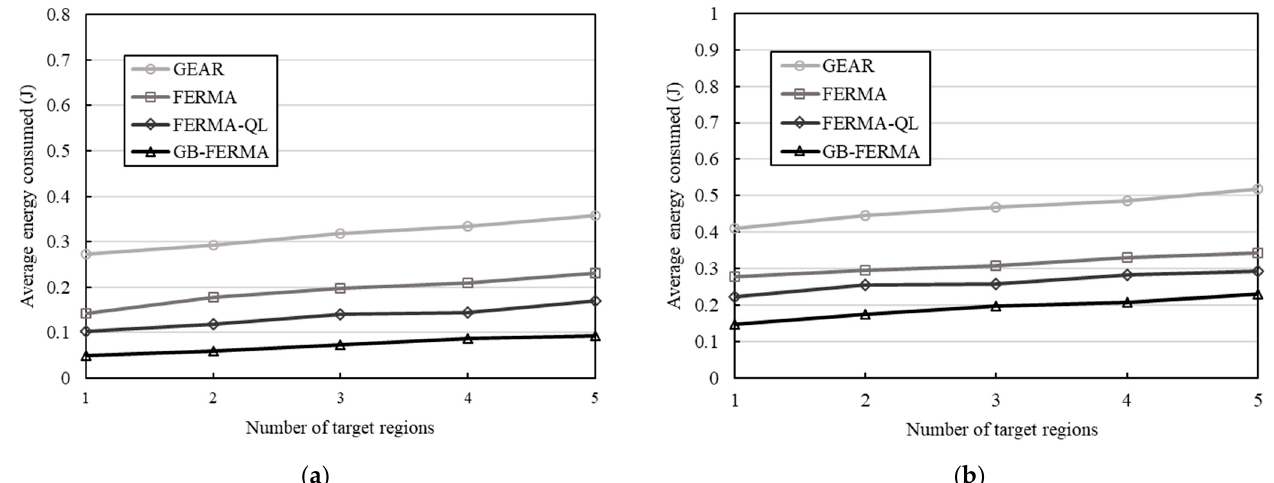
Figure 8. Average energy consumed versus number of target regions: ( a ) initial power 0.25 J; ( b ) initial power 0.5 J.